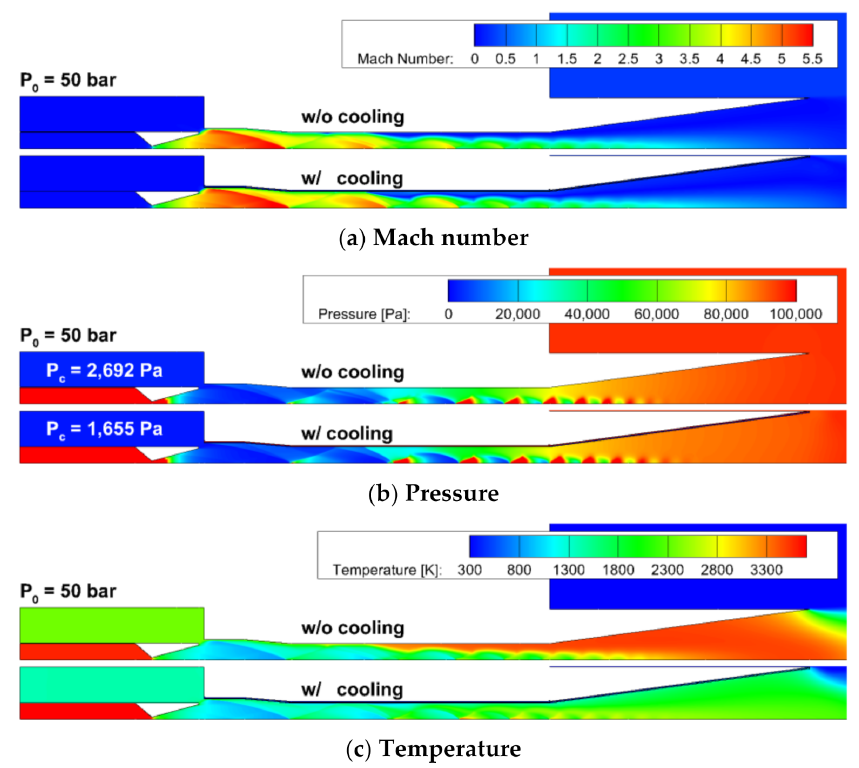
Figure 15. Cooling effects of the baseline diffuser at P 0 = 50